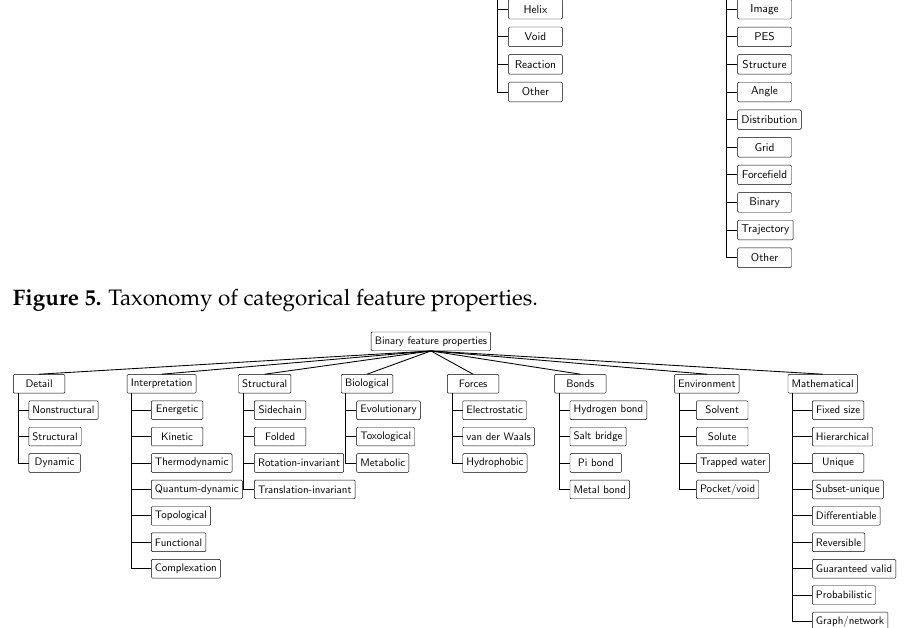
Figure 6. Taxonomy of binary feature